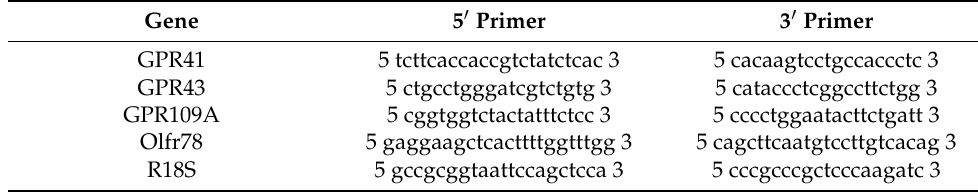
Table 1. qPCR primer sequences.